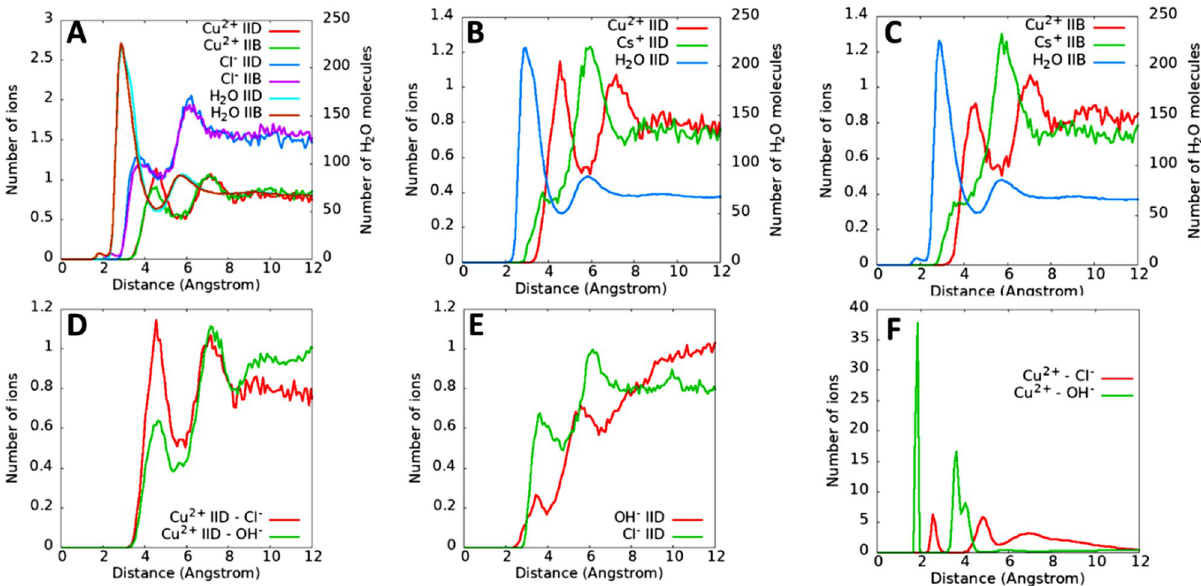
Figure 2. Number of ions (Cu 2+ and Cl − ) and water molecules as a function of the distance to the closest kerogen atoms ( A ). Comparison of Cu 2+ and Cs + adsorption between kerogen IID ( B ) and IIB ( C ) surfaces. Comparison of Cu 2+ ion adsorption for the systems with and without OH − ions, i.e., for IID-CuCl 2 (red) and IID-Cu(OH)Cl (green) systems ( D ). Comparison of OH − and Cl − ion adsorption on kerogen IID obtained